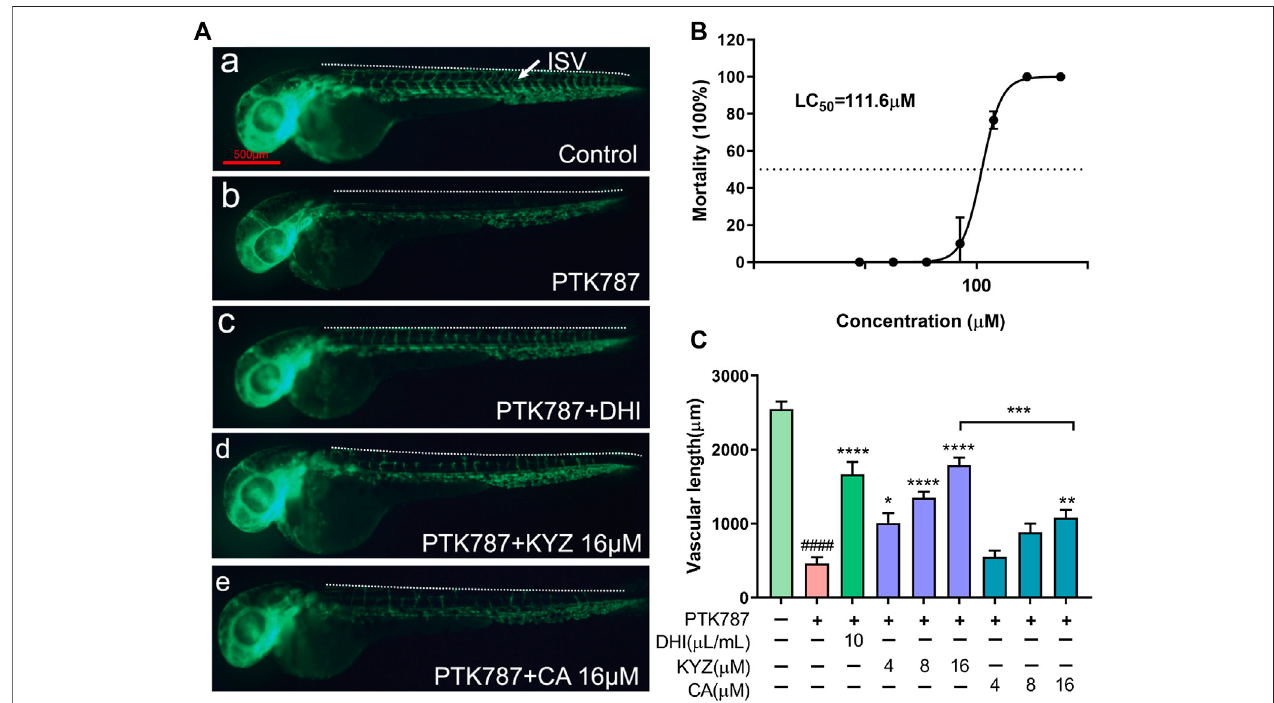
FIGURE 3 | Repair effects of different concentrations of KYZ and CA on PTK787-induced ISVs injury in zebra fi sh. (A) KYZ treatment rescued the zebra fi sh ISVs injury induced by PTK787. Lateral view of the zebra fi sh treated with PTK787, PTK787 + DHI, PTK787 + KYZ (4,8,16 μ M), and PTK787 + CA (4,8,16 μ M) for 24 h, respectively.DHIwasusedaspositivecontrol,andthewhitearrowindicatestheintersegmentalvessel(ISV). (B) The24hpf Tg( fl i1:EGFP) linezebra fi shweretreatedwith different concentration KYZ. After treatment for 24 h, the number of death larvae was counted and converted into percentages, and LC 50 was calculated by Graphpadprism8.0.software. (C) QuantitativeanalysisofthetotallengthofISVinzebra fi shbyKYZandCAtreatment,andthedataareexpressedasmean±SEM.One- way ANOVA was used for statistical analysis (n = 12). * p < 0.05, ** p < 0.01, *** p < 0.0001, **** p < 0.0001, #### p < 0.0001 compared with control group. Scale bars is 500 μ m.